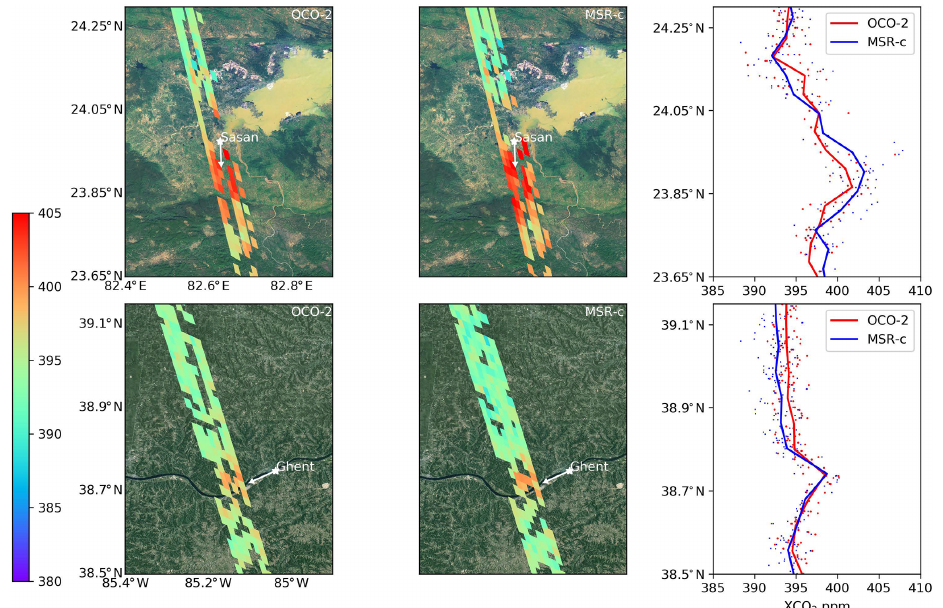
Figure 7. XCO 2 retrievals along orbits with hot spots as observed by OCO-2 and MSR-c instruments. Local potential sources (power plant) are marked by asterisks and the directions of the local wind are marked with arrows. For each hotspot overpass, XCO 2 values (scatter dots) and median values (solid lines) along the orbit are shown in the right most panel. Here, OCO-2 passes by the Sasan and Ghent power plants on 23 October 2014 and 13 August 2015, respectively. Mean biases reported in Table 5 are removed from each orbit. Base map derived from Esri ArcGIS